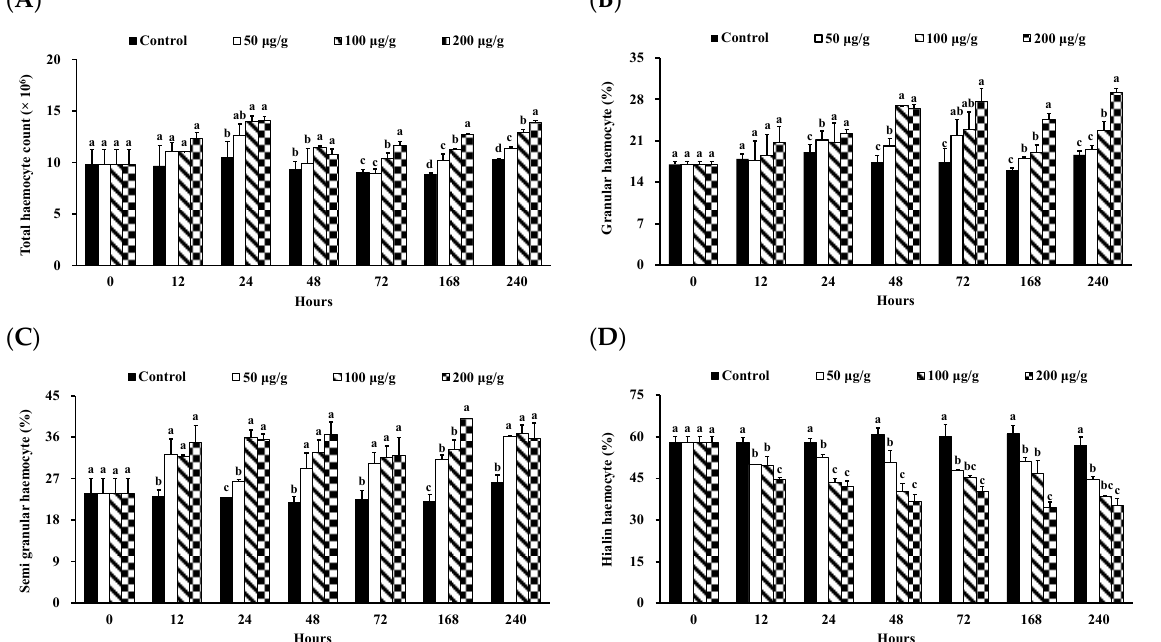
Figure 2. THC ( A ), GC ( B ), SGC ( C ), and HC ( D ) of Litopenaeus vannamei that received the PNWE at 50, 100, and 200 μ g (g shrimp) − 1 and control shrimp. Data are expressed as mean ± SD ( n = 8). Different superscript letters indicate that the same exposure time significantly differs ( p < 0.05) among groups (Duncan’s multiple range tests). PNWE: Panax notoginseng water extract. The phagocytosis and PO activity of L . vannamei injected with different concentrations of the PNWE are shown in Figures 3 and 4. From 12 to 240 h, the RB activity was significantly higher than that of the control in different concentrations of the PNWE ( p < 0.05) (Figure 3A). The most significant RB activity was observed in L . vannamei injected with 100 and 200 μ g (g shrimp) − 1 of the PNWE at 12 to 48 h. However, the most significant increase in RB activity was observed in L . vannamei injected with 200 μ g (g shrimp) − 1 of the PNWE from 72 to 240 h. The PR (Figure 3B) and the PI (Figure 3C) of L . vannamei injected with different concentrations of the PNWE were significantly higher than that of the control ( p < 0.05) from 12 to 240 h. The increase in PI was most significant in the group injected with 100 and 200 μ g (g shrimp) − 1 of the PNWE. From 12 to 240 h, the PO activity of L . vannamei injected with different concentrations of the PNWE was significantly higher than that of the control in different concentrations of the PNWE ( p < 0.05; Figure 4). ( A )